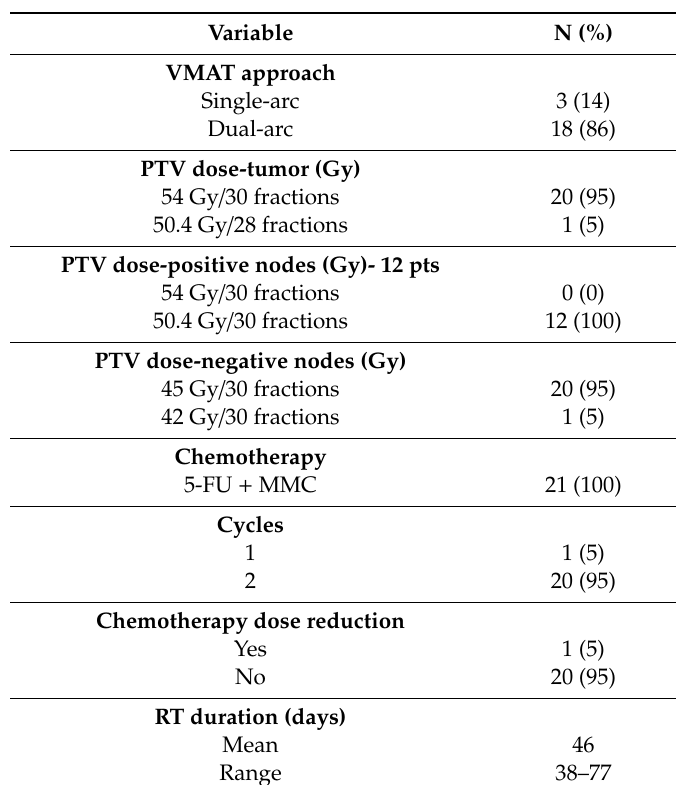
Table 3. Treatment